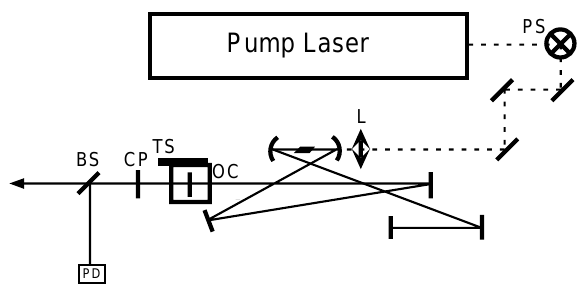
FIG. 6. The Ti:Al 2 O 3 laser oscillator layout. All components are mirrors unless labeled. PS: periscope; L: focusing lens; OC: output coupler; CP: compensating plate; BS: beam splitter; PD: photodiode; and TS: translation stage. The solid line is the 800 nm oscillator beam, the dashed line is the 532 nm pump